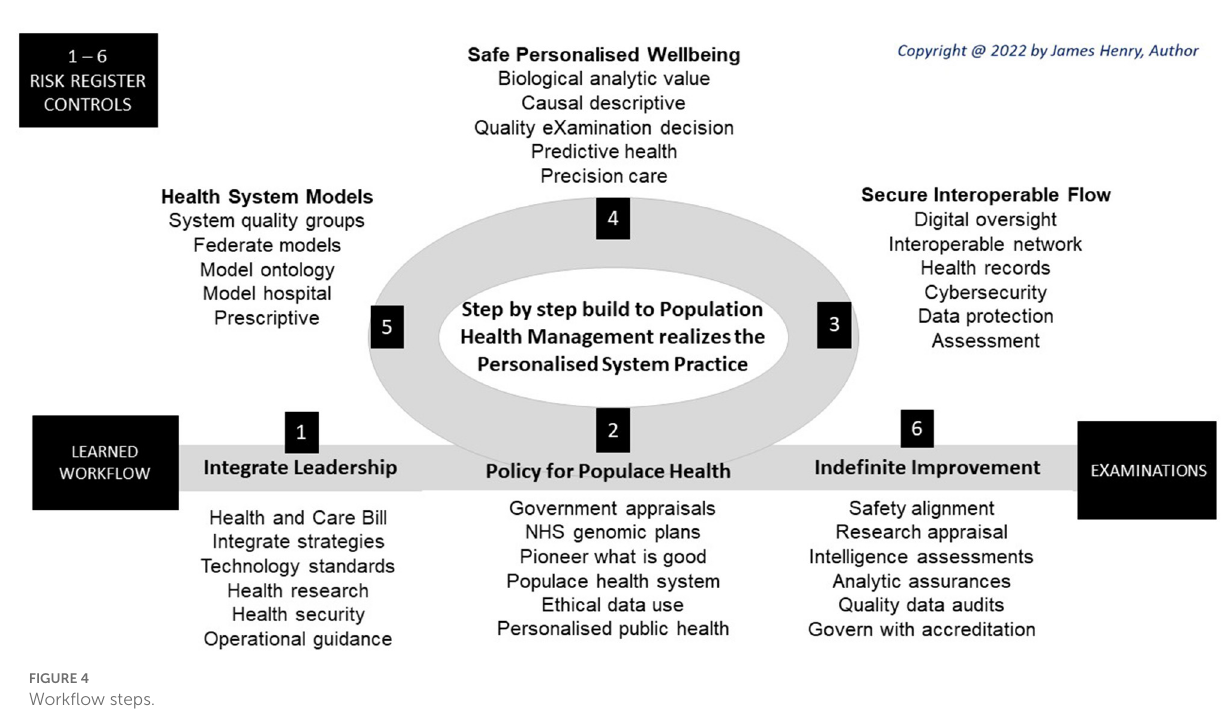
FIGURE4 Workflow